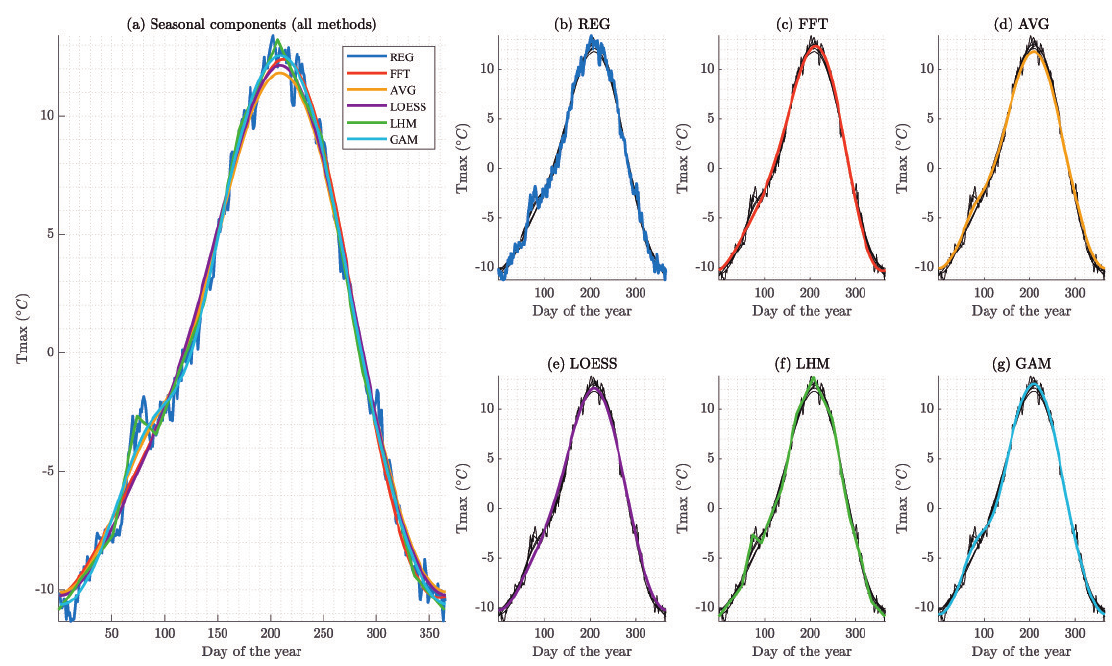
Figure 3. Seasonal component for the maximum temperature of Spain. ( a ) Estimated by all the proposed methods of Table 1. ( b ) Estimated by REG. ( c ) Estimated by FFT. ( d ) Estimated by AVG. ( e ) Estimated by LOESS. ( f ) Estimated by LHM. ( g ) Estimated by GAM. ( b – g ) Black lines in background represent the seasonal components estimated by all the rest of the models of Table